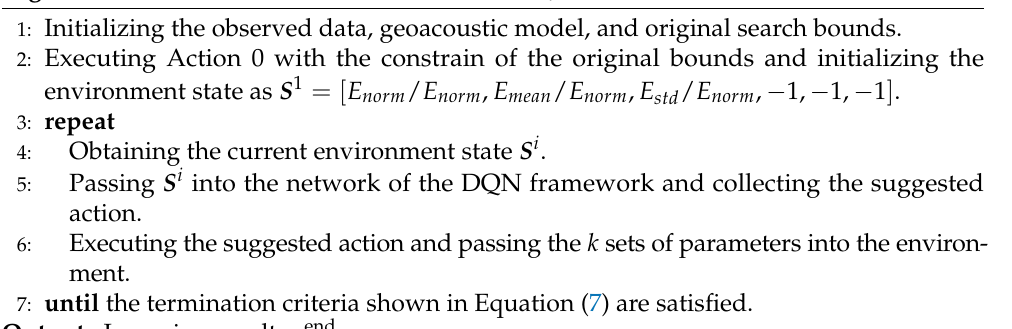
Algorithm 2 Inversion workflow based on the DQN